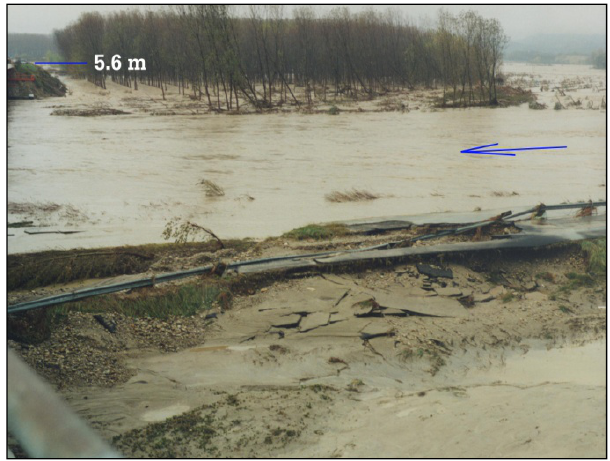
Fig. 4 – The Mussotto quarter, close to the highway (W in Fig. 2). The neighboring Asti-Cuneo embankment, acting as a dam, retained the Tanaro floodwaters, which reached the second floor of the houses (red arrow). In the center, a fire department rescue boat is in action.